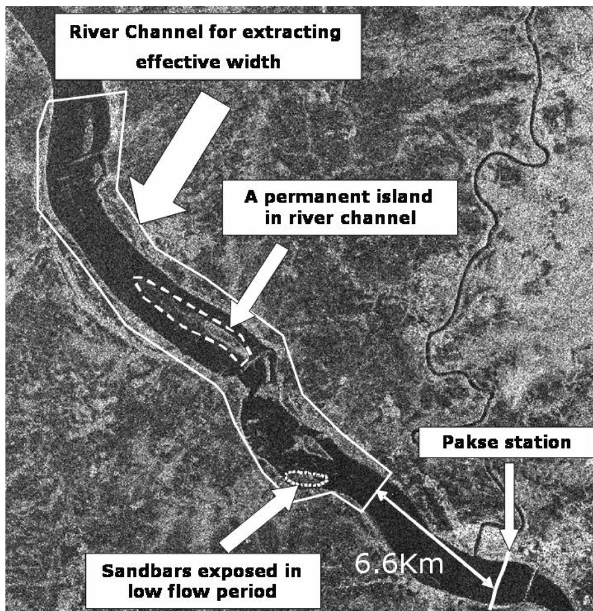
Fig. 3. The selected reach at Pakse for measuring river width from JERS-1 SAR images and examples of the area elements being mea-